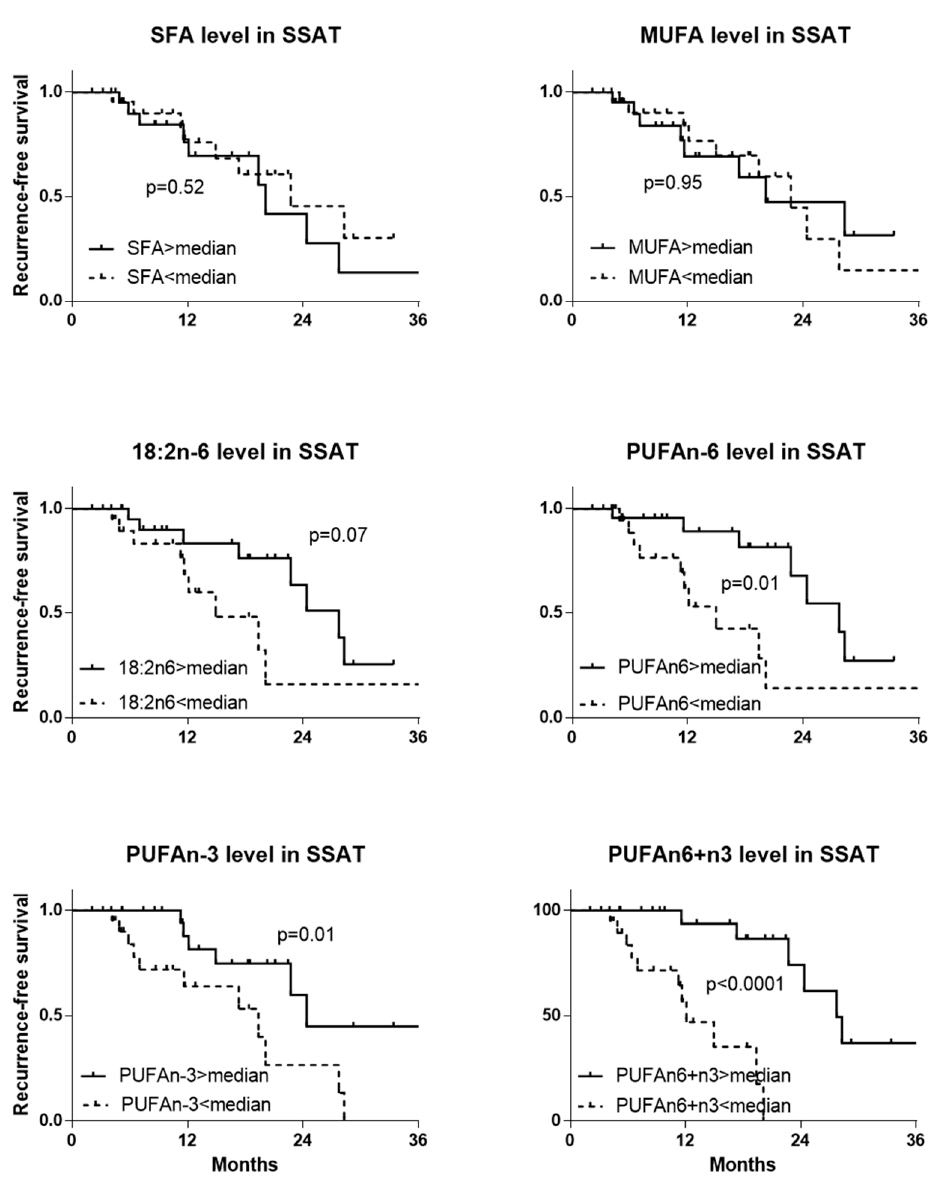
Figure 2. Recurrence-free survival in patients with EOC by fatty acid content in superficial subcu- taneous adipose tissue. Analysis of recurrence-free survival with the Kaplan–Meier method and log-rank test. Patients were divided into two groups by fatty acid content (<median, n = 23 or >median, n = 23) ( n = 46). SFAs: saturated fatty acids, MUFAs: monounsaturated fatty acids, PUFAs: polyunsaturated fatty acids, SSAT: superficial subcutaneous adipose tissue, 18:2n-6: linoleic acid.